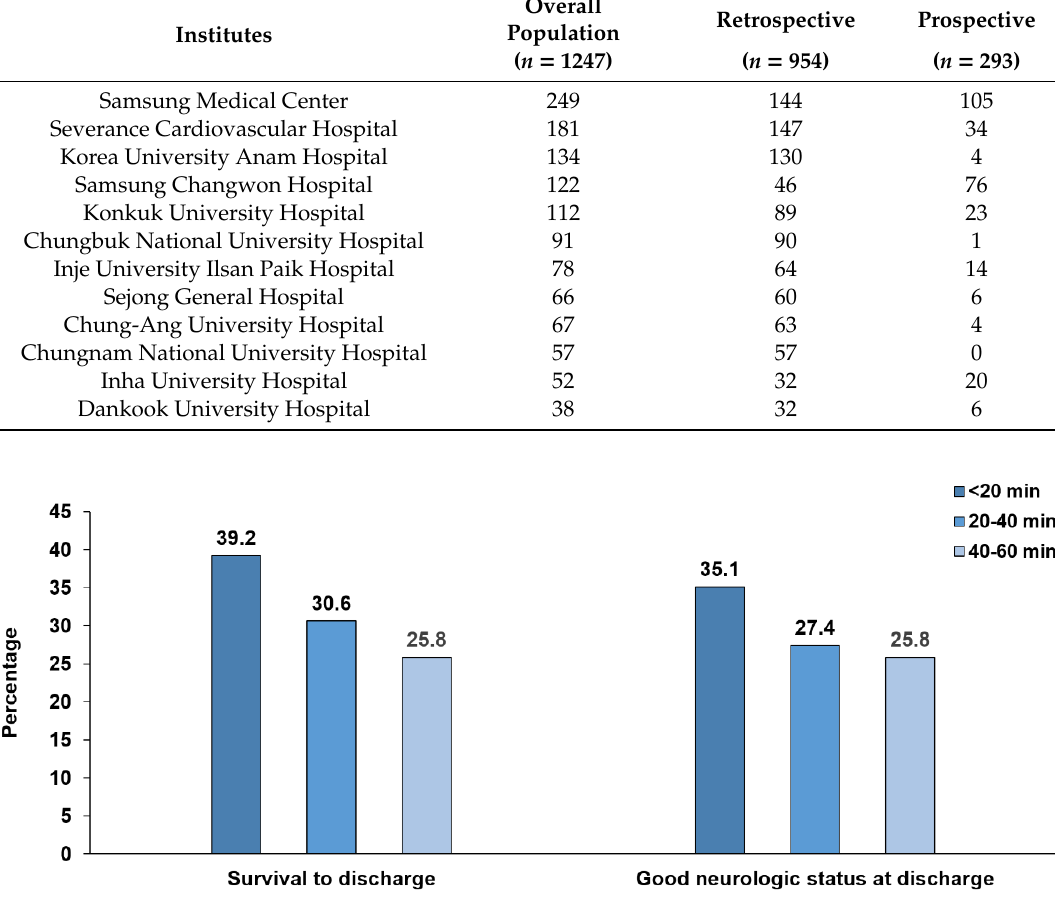
Figure A1. Relation between ECPR duration and clinical outcomes. Bar plots show the relation between ECPR duration and survival to discharge or good neurological outcomes at discharge. ECPR = extracorporeal cardiopulmonary resuscitation.